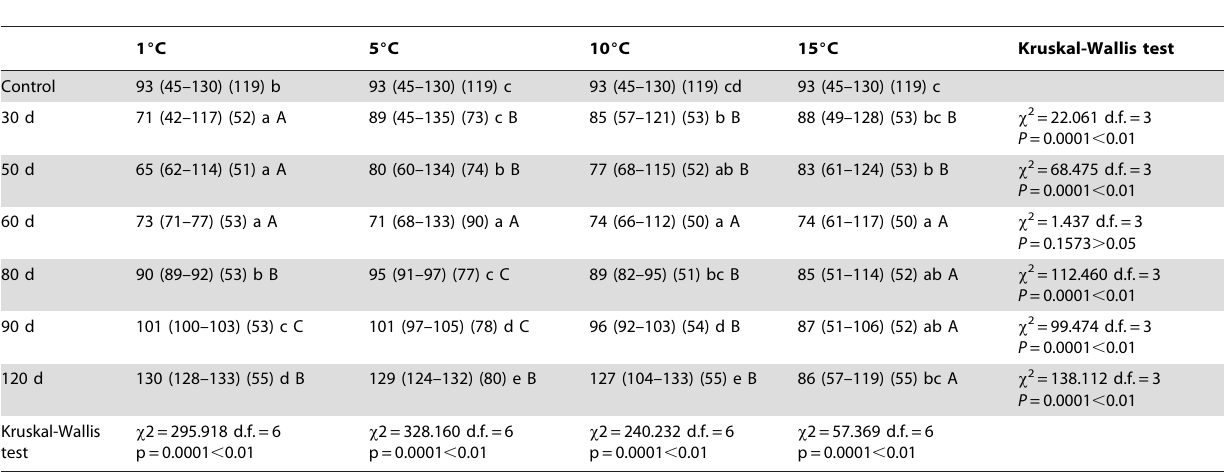
Table 2. Effects of low temperature chilling on diapause termination and post diapause development in hibernating pupae of P. melete